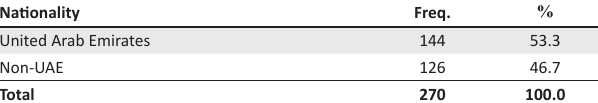
TABLE 1b: Background of respondents.